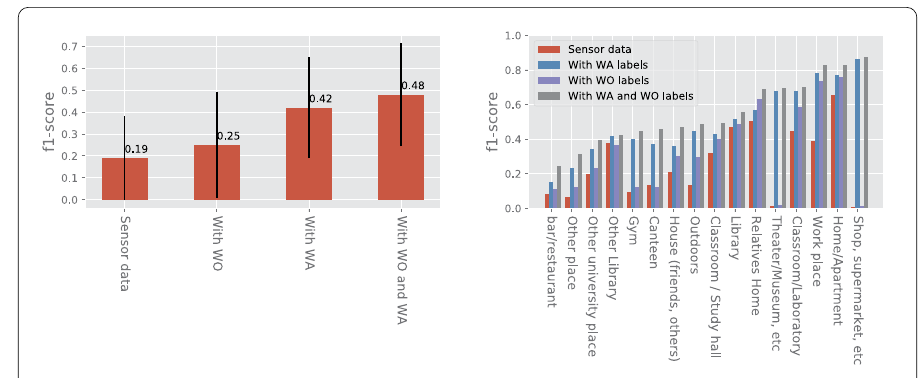
Figure 7 Left: Macro mean F 1 scores achieved by a Random Forest classifier for location using sensors only, sensors with WO, sensors with WA, and sensors with WO and WA. Right: per-label F 1 score achieved by the same classifier for individual